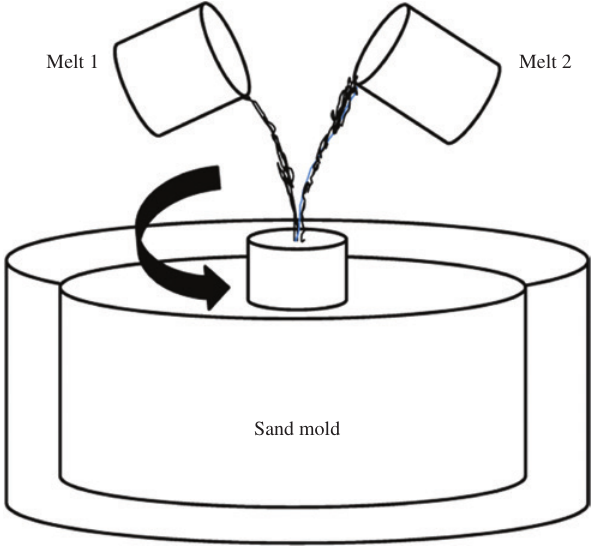
Figure 28: Centrifugal casting process.